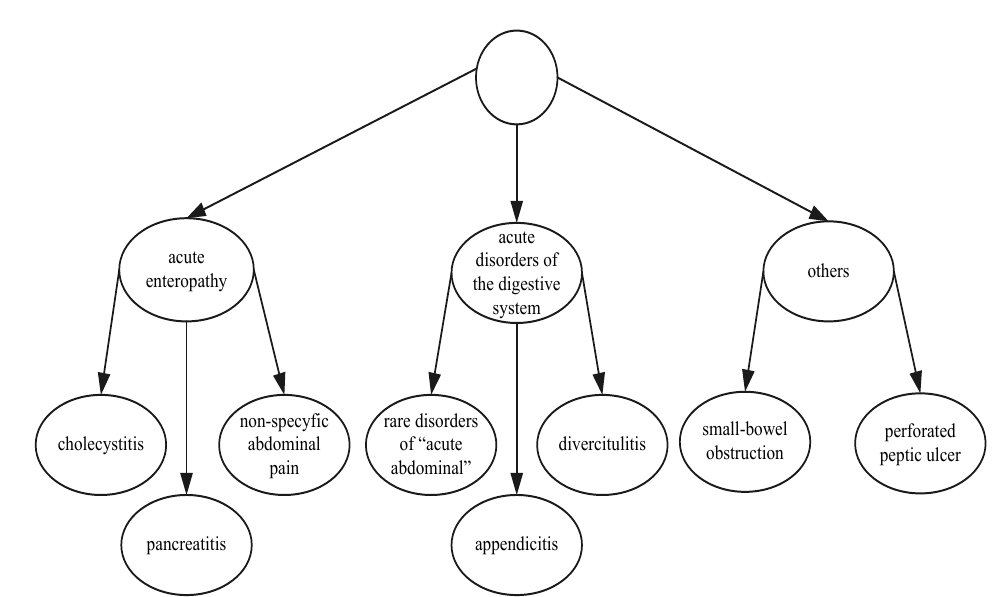
Figure 4. Heuristic classifier for the APP diagnosis